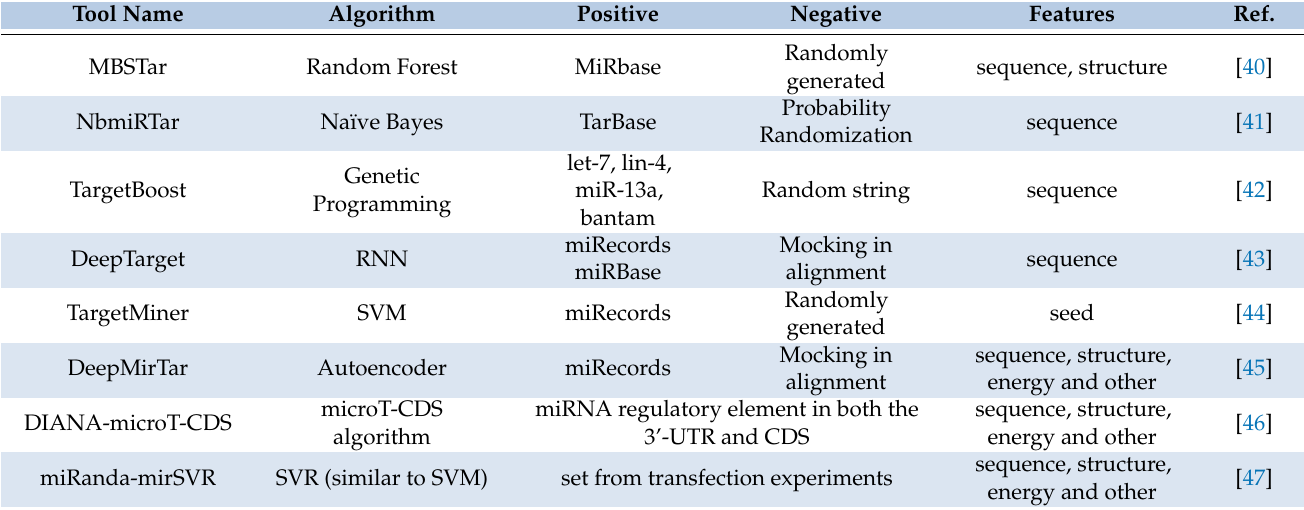
Table 2. List of ML prediction tools with the kinds of used strategies. For an explanation of the algorithms, see Box 1. Tool Name